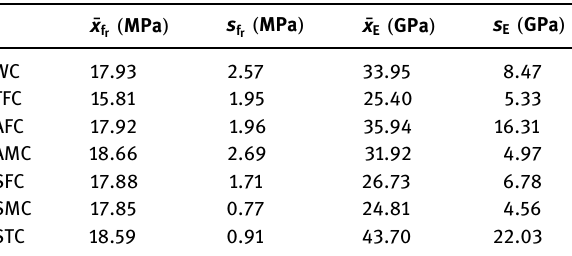
Table 3: Results for tensile strength and Young ’ s modulus